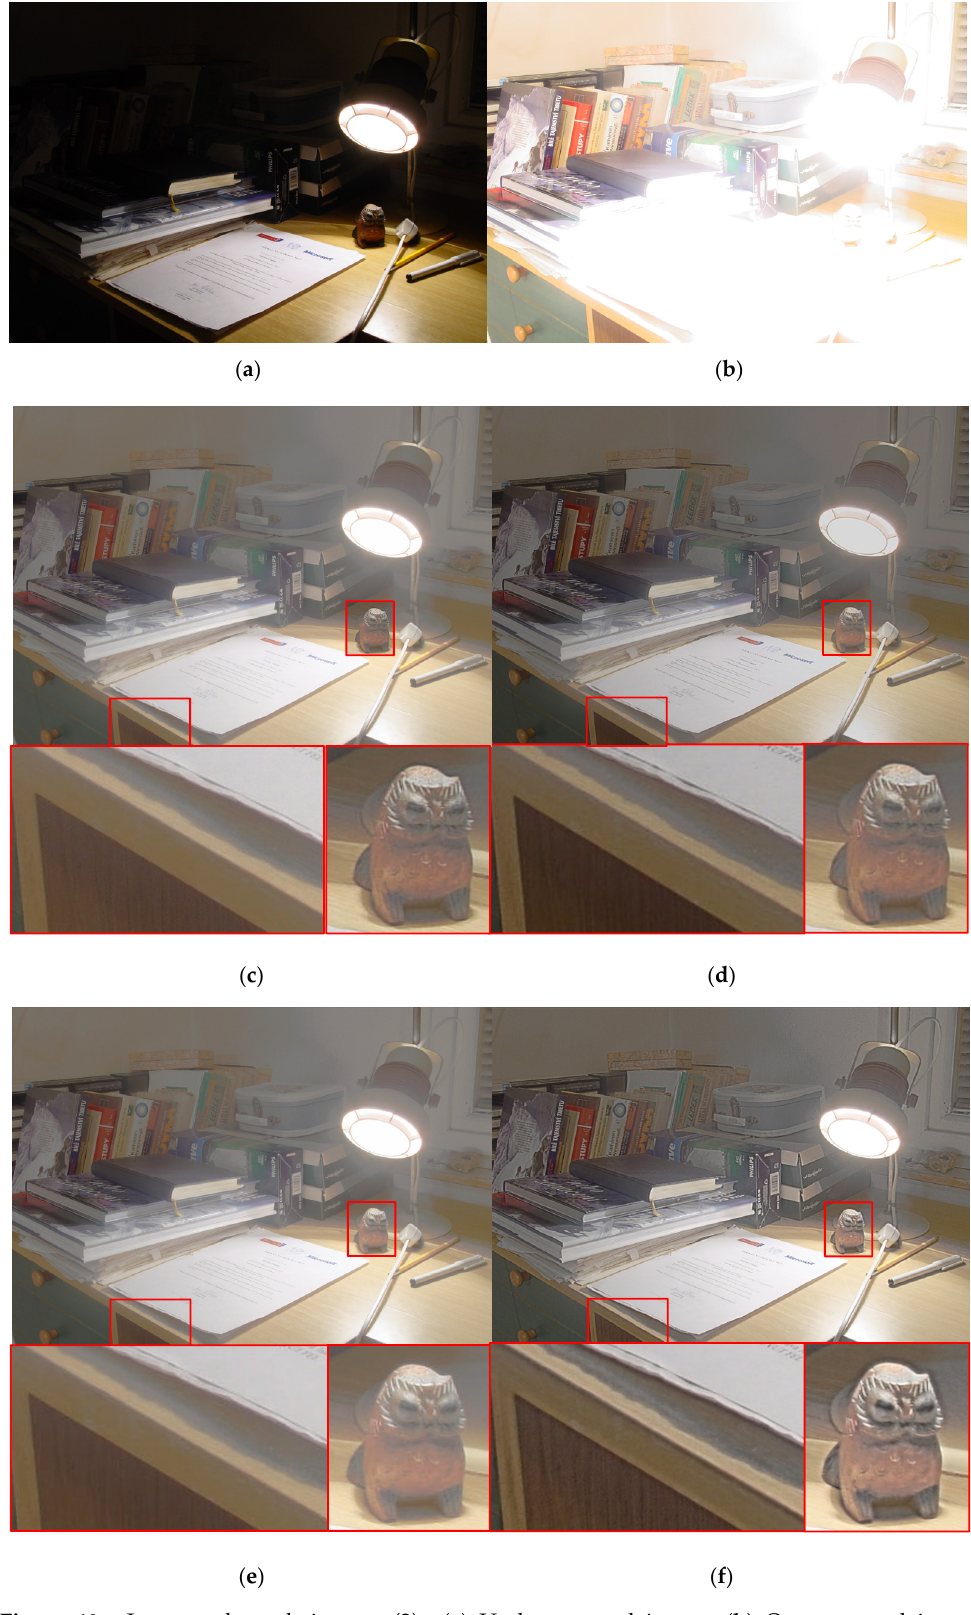
Figure 12. Input and result images (2): ( a ) Under-exposed image, ( b ) Over-exposed image, ( c ) DenseFuse, ( d ) U2Fusion, ( e ) TransMEF, ( f ) Proposed model.